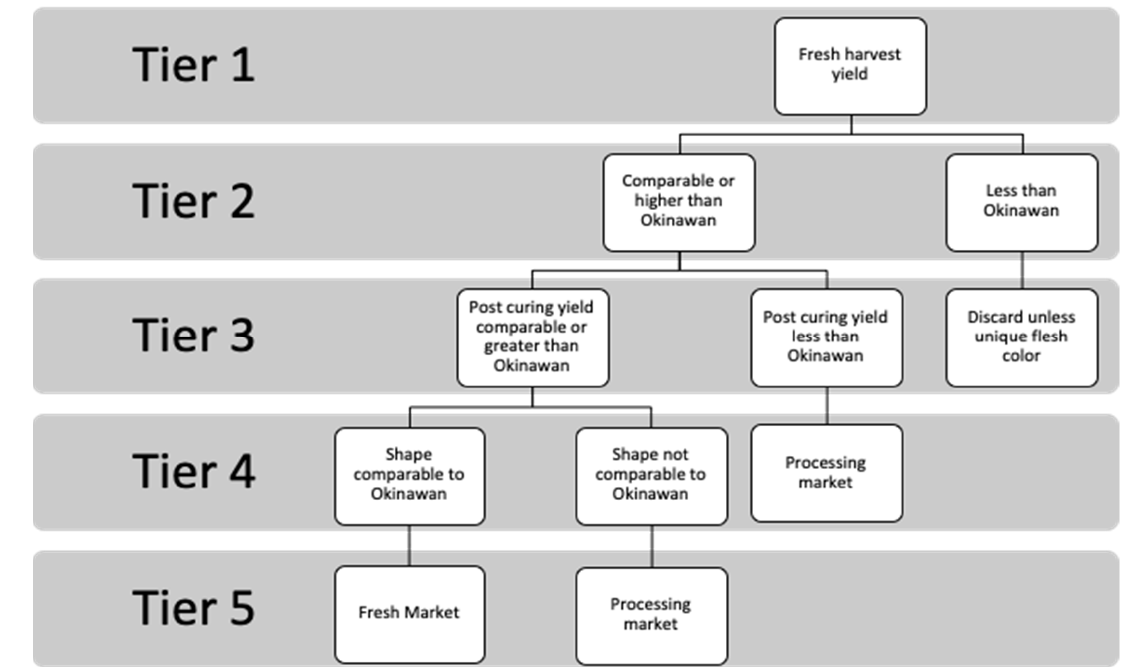
Figure 3. Selection roadmap for ‘Hawaiian Heritage’ cultivars. There are two primary selection targets. These are fresh market (or unprocessed) and for the processing market (brewing lines). Each selection trait is compared to the commercial standard Okinawan and Hawaiian cultivars at each tier. There are two entry points within this selection scheme at Tier 1; the first is before curing as this is not a common practice in Hawaii and the second is after curing, which is the industry standard. The fresh harvest yield is more relevant for processing and local consumption. In contrast, curing adjusted yield is more important for potential export, mainland, or if curing is more widely adopted locally. Selection occurs at each tier as a point of assessment for the breeding line.